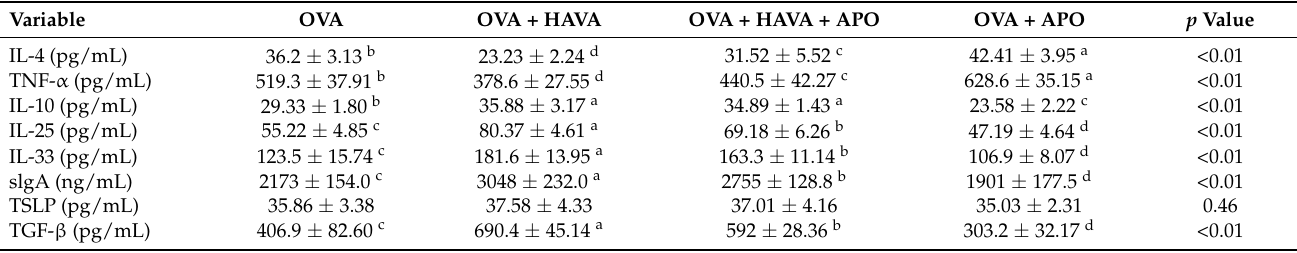
Figure 7. The heat shock protein 70 (Hsp70) inhibition weakened the antiallergic effect of avenan- thramide (AVA) in ovalbumin (OVA)-induced food allergy mouse model in experiment 2. ( A , B ) Total IgE and OVA-specific IgE (OVA-IgE) in the serum, ( C – E ) interferon- γ (INF- γ ), interleukin-4 (IL-4), and IL-13 in the serum, ( F ) plasma histamine, ( G – I ) prostaglandin D (PGD), platelet factor (PAF), and mouse mast cell protease 1 (mMCP-1) in the serum. OVA: mice orally challenged with OVA; OVA + HAVA: an OVA-challenged group that was oral gavaged with a high dose of 20 mg/kg bw avenanthramide (AVA); OVA + HAVA + APO: the OVA + HAVA group coupled with apoptozole (APO); OVA + APO: the OVA group coupled with APO. Results are presented as means ± SDs ( n = 8). Bars with no letter in common are significantly different, p ≤ 0.05. Table 2. Cytokines in the jejunum in experiment 2.